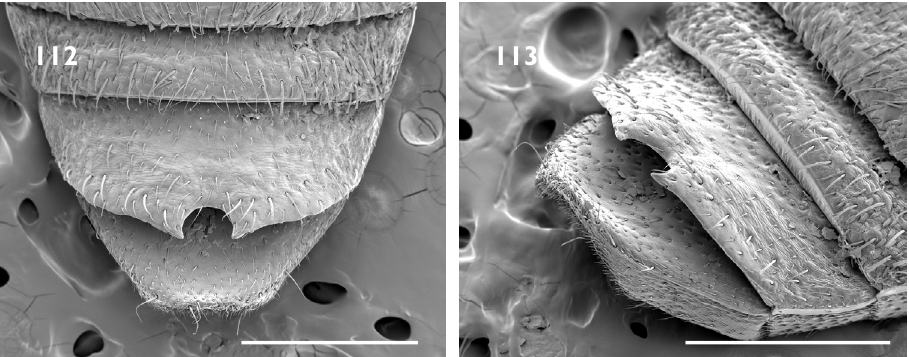
Figures 112–113. SEM photographs of abdominal ventrites 4 and 5 of female Austromonticola rotundus. 112 ventral view 113 ventroposterolateral view. Scale bars = 0.5 mm.